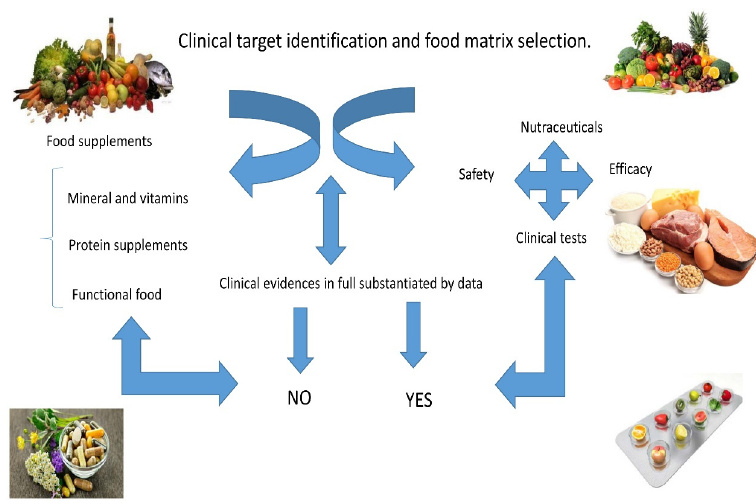
Figure 1. Food supplements and nutraceuticals.